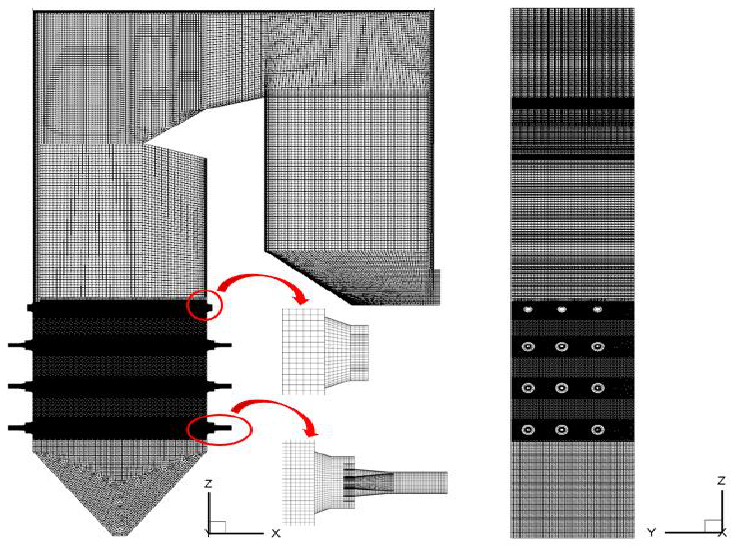
Figure 4. Grids formed in furnace.